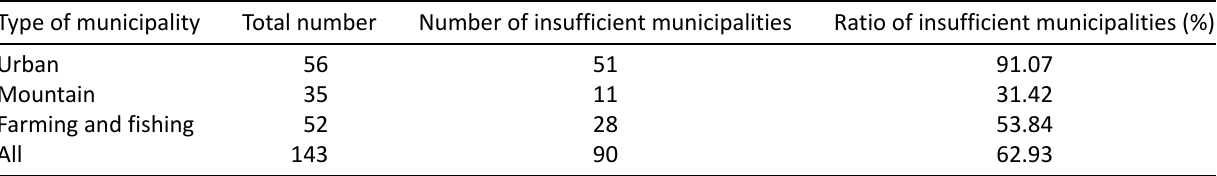
Table 9. Ratios of municipalities with insufficient levels of heat wave adaptation policies compared to the heat wave effects by municipality